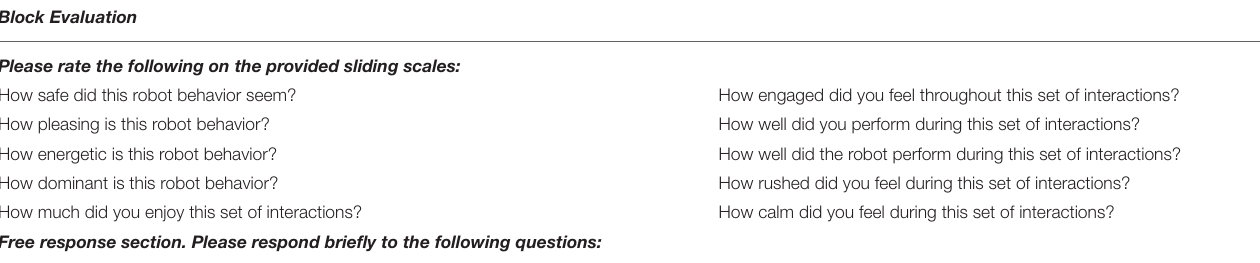
TABLE 1 | Content of the block questionnaire used in the bimanual clapping study. Block